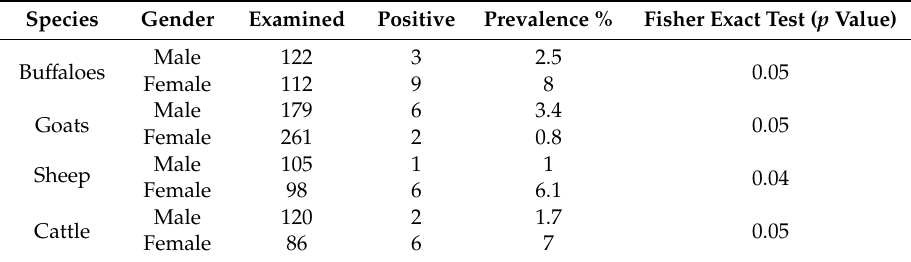
Table 1. The e ff ect of species and sex on seroprevalence of brucellosis. Species